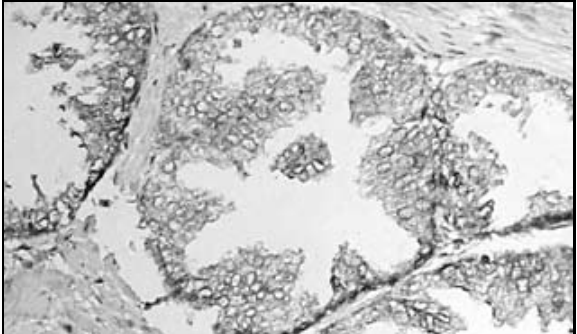
Figura 3 – Imuno-histoquímica para galectina-3 em tecido prostático com adenocarcinoma (magnificação